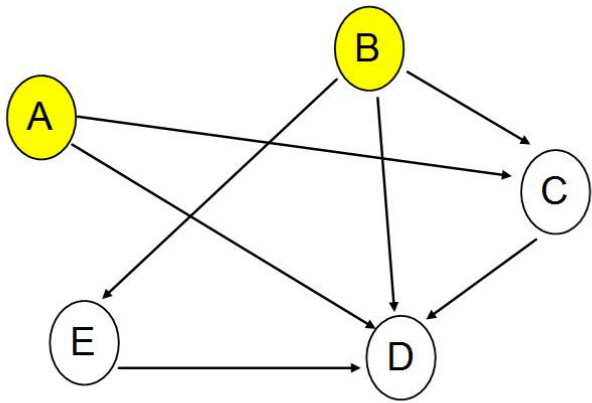
Fig. 4. ELECTRE graph and kernel showing the best alternatives to control of desertification in Salta, sub zone La Estrella.